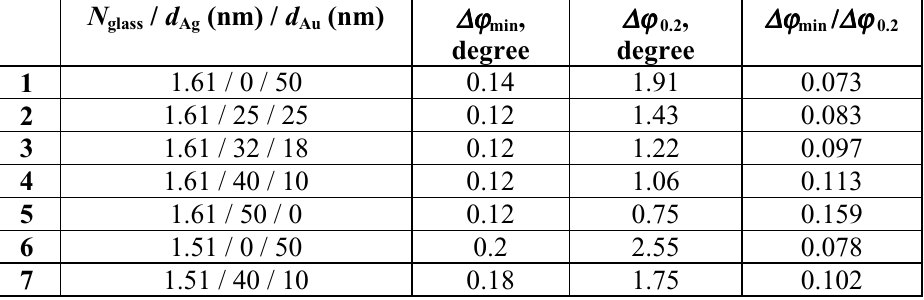
Table 1. Results of computer simulation of SPR curves ( ∆ Ns=0.015